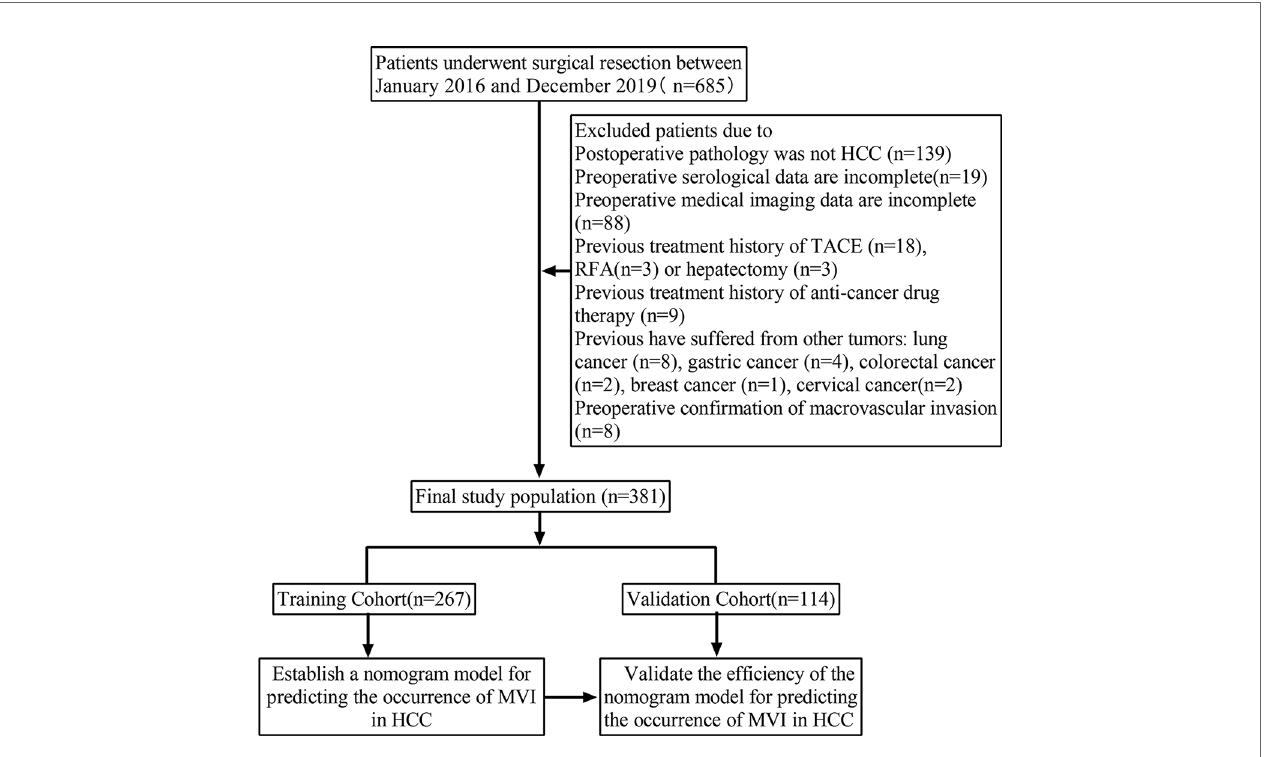
FIGURE 1 | Flow chart of patients screening and